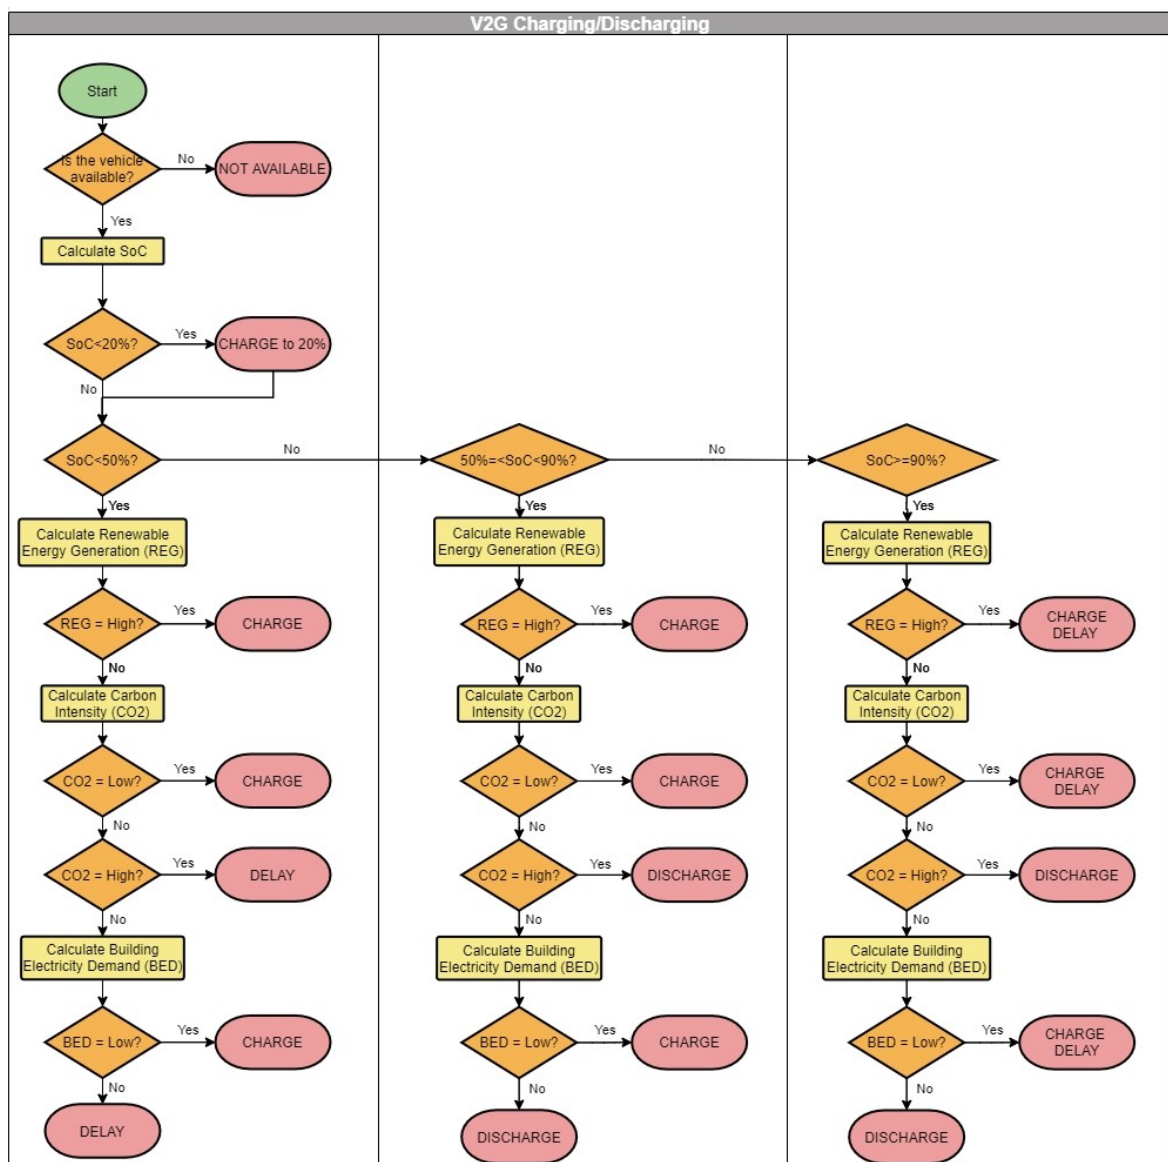
Figure 3. Flowchart to calculate the best option to charge/discharge EVs, prioritising environmental Figure 3. Flowcharttocalculatethebestoptiontocharge/dischargeEVs, benefits.